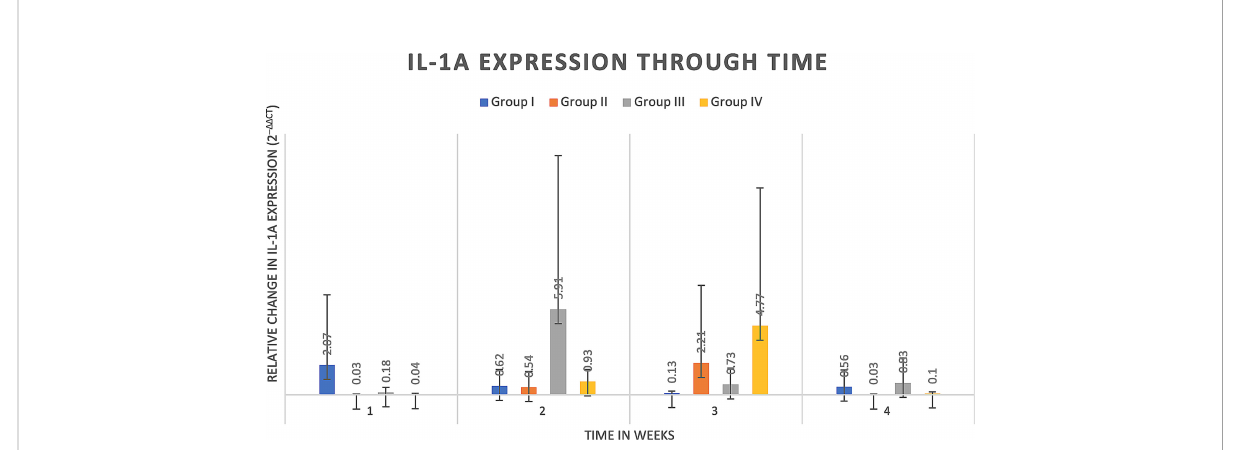
FIGURE 6 IL-1a expression through time expressed as relative fold gene expression. IL-1a expression in Group IV was signi fi cantly greater at week three compared to week one (p=0.0003) and signi fi cantly greater at week three than week four (p=0.0228).